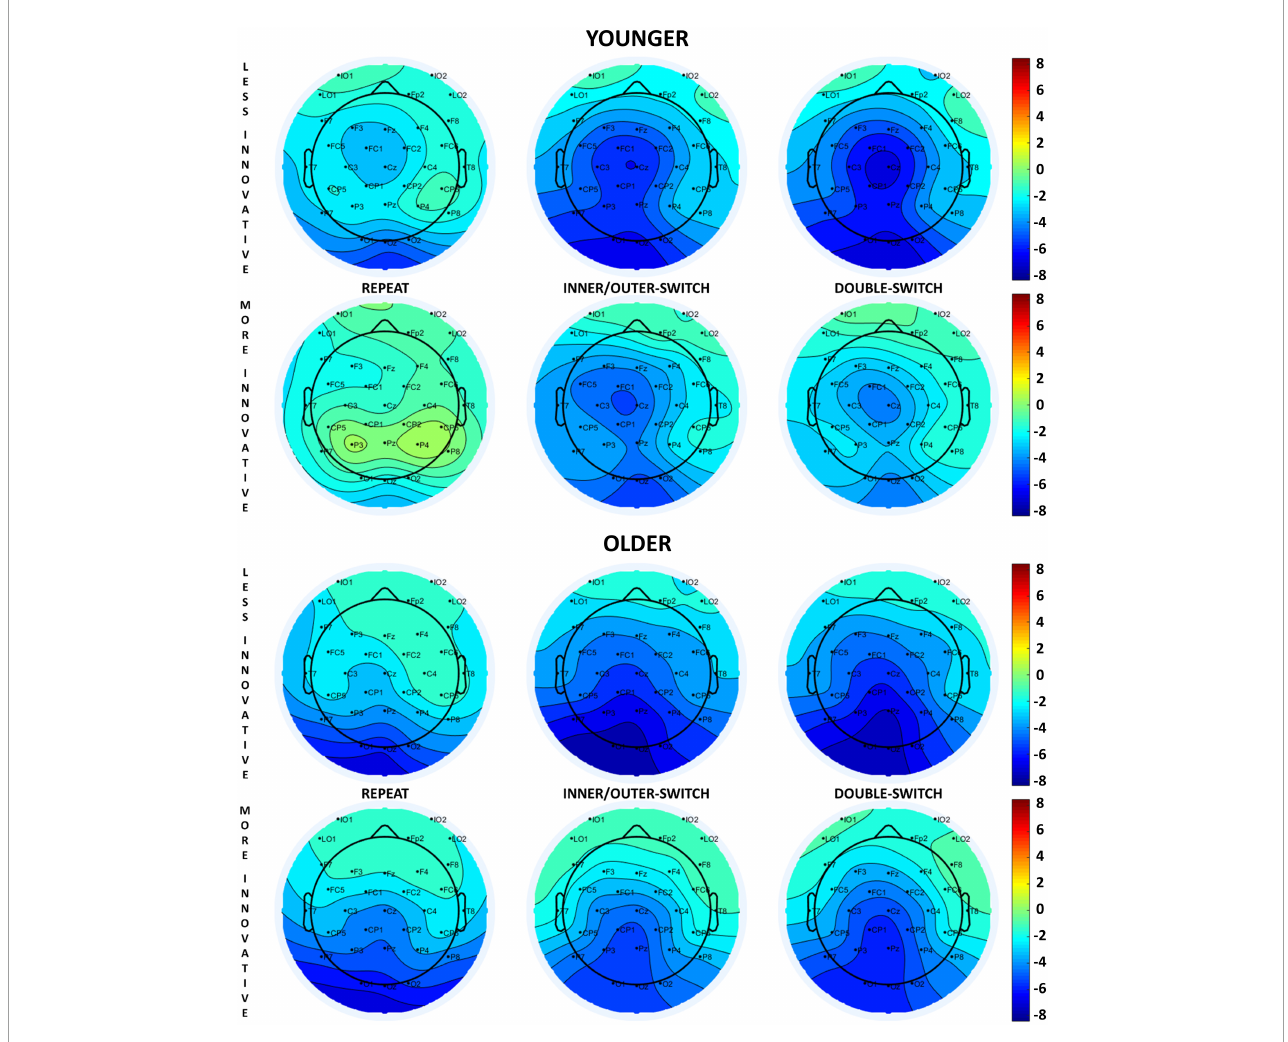
FIGURE5 Scalp distributions of the target-locked N2b component for each Switch-type in the innovative creativity groups at: 280 ms for younger adults and 300 ms for older adults (relative to the presentation of the target